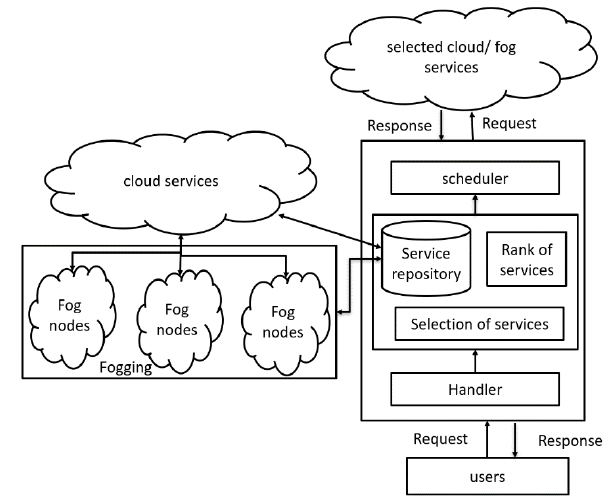
Figure 1. Foglet architecture.